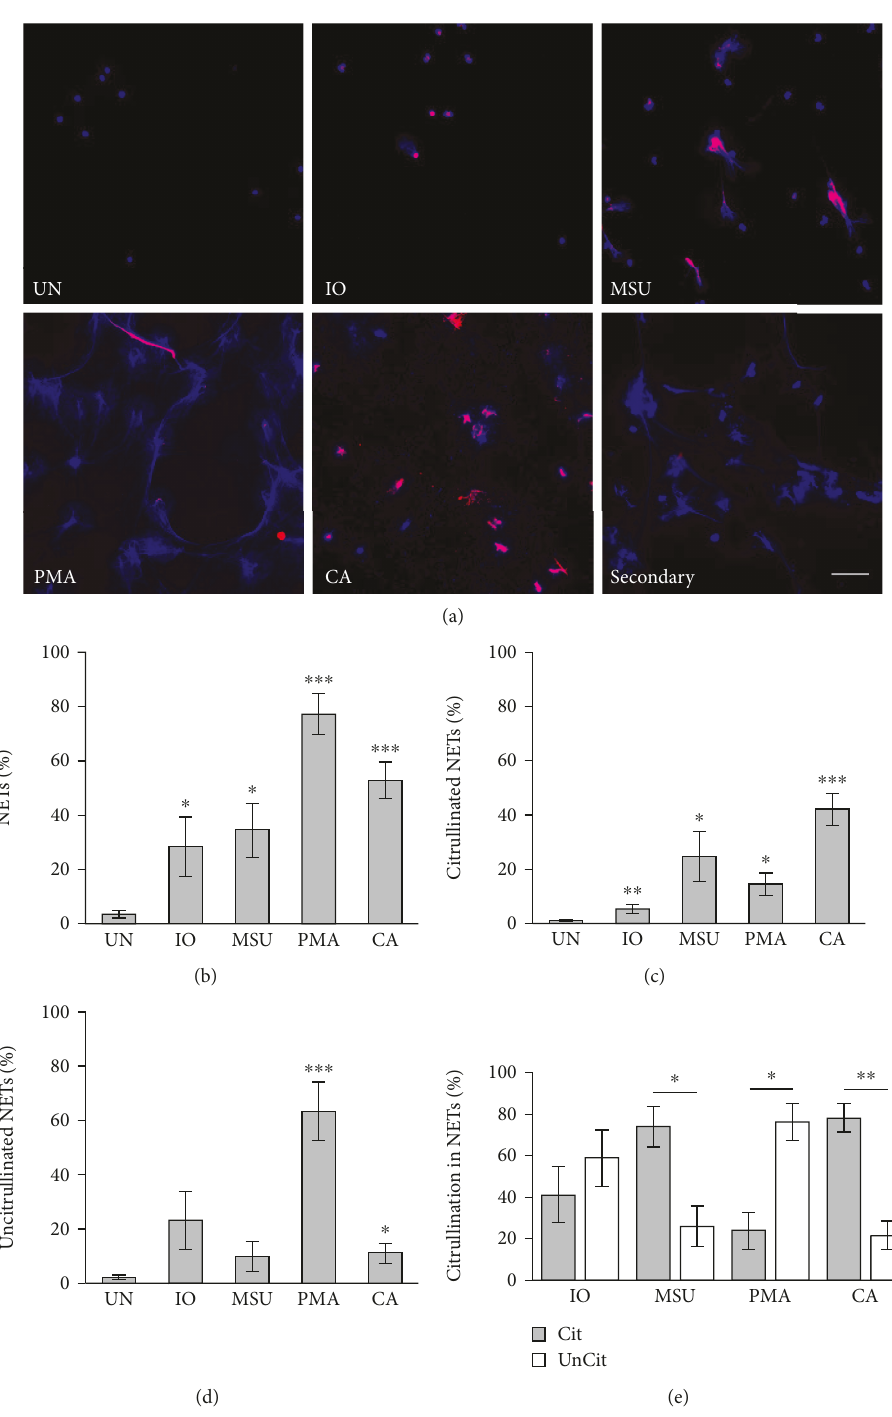
Figure 1: Induction of NETs in human neutrophils. Human neutrophils were left untreated (UN) or were treated with ionomycin (IO), MSU, PMA, or C. albicans (CA), fi xed, and stained with DAPI (blue) and anti-citrulline antibody (pink). Image labeled “ Secondary ” was created by stimulating neutrophils with C. albicans and staining without the F95 primary antibody and only the anti-mouse IgM-TRITC secondary antibody as a negative control. (a) Representative images at 400x, scale bar = 50 μ M . The number of neutrophils and NETs were quanti fi ed. Graphs depict the average and SEM for percent of neutrophils that formed total NETs (b), citrullinated NETs (c), and uncitrullinated NETs (d) for each condition with percent NETs for each stimulant compared to untreated. (e) The percent of citrullinated versus uncitrullinated NETs was compared for each stimulus with average and SEM graphed. For all panels: n = 9 ; ∗ p < 0 05 , ∗∗ p < 0 01 , and ∗∗∗ p < 0 001